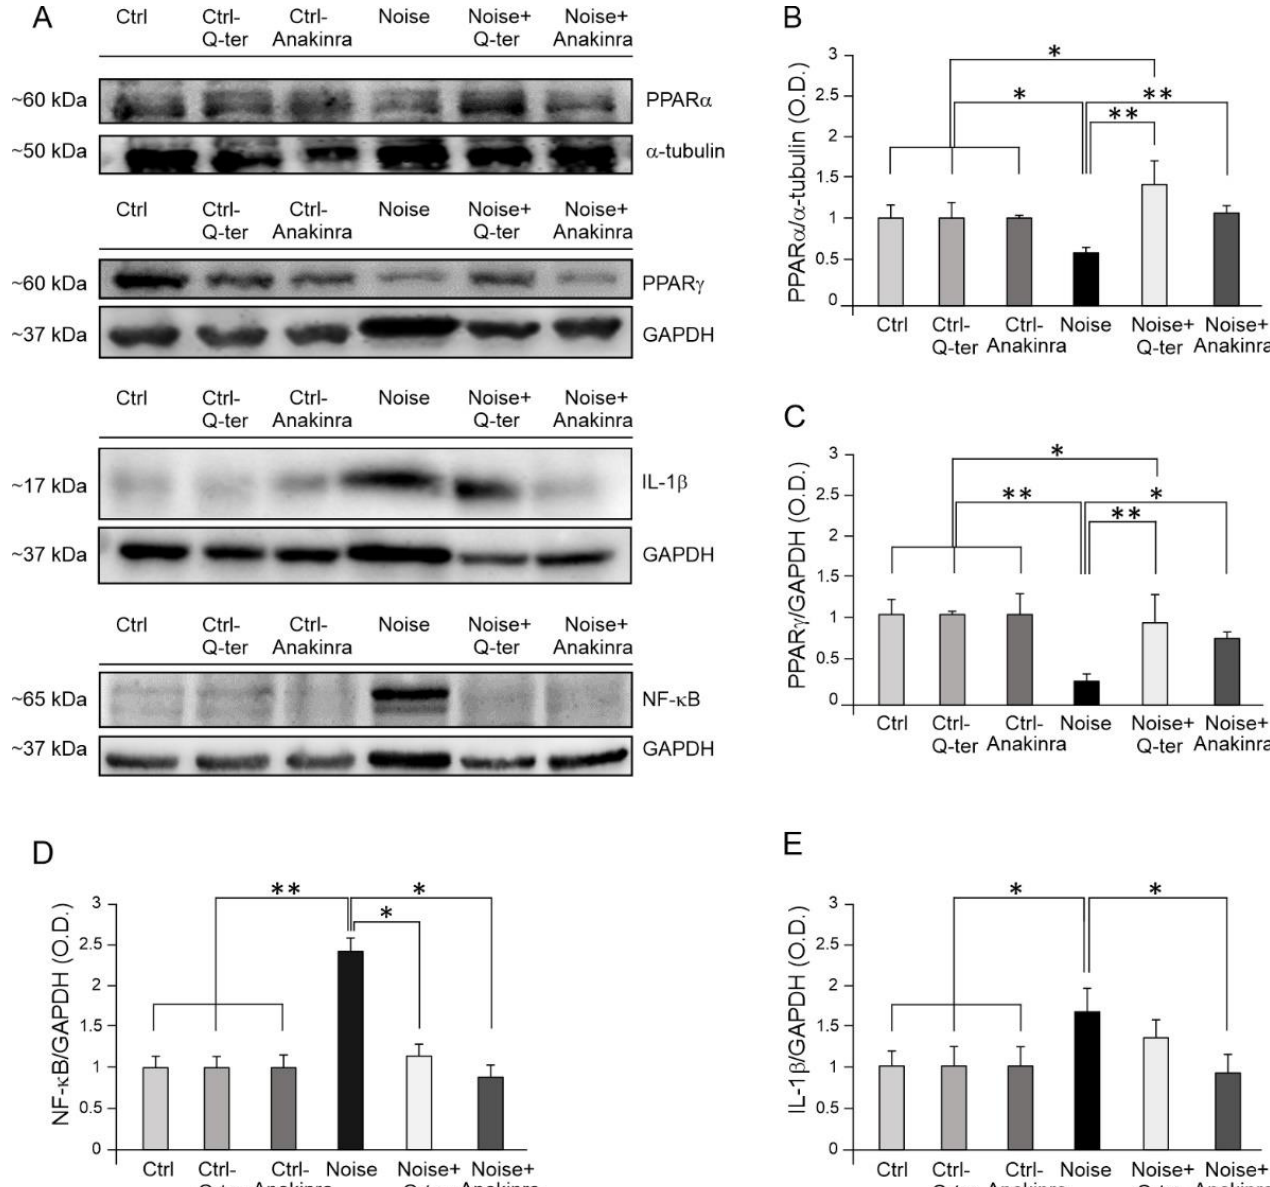
Figure 6. Cochlear PPAR and inflammatory marker expression in Q-ter and Anakinra-treated samples. ( A ): Western immunoblotting showing cochlear expression of PPAR α , PPAR γ , NF- κ B and IL-1 β in animals exposed to noise and treated with Q-ter or Anakinra (day 7 after acoustic trauma). ( B – E ): Histograms showing densitometry evaluations (O.D., proteins/GAPDH ratios). Data are expressed as mean ± SEM from three independent experiments. Asterisks indicate significant differences between groups (* p < 0.05; ** p < 0.01).